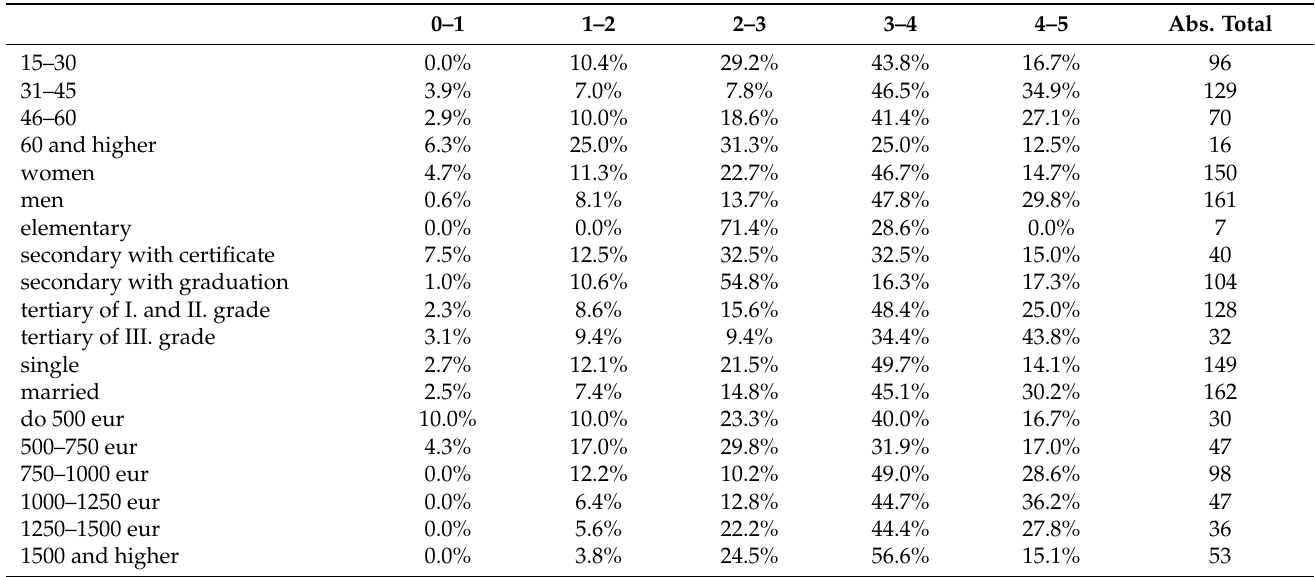
Table 3. Share of population within intervals of mental health score by age, gender, education, marital status and level of